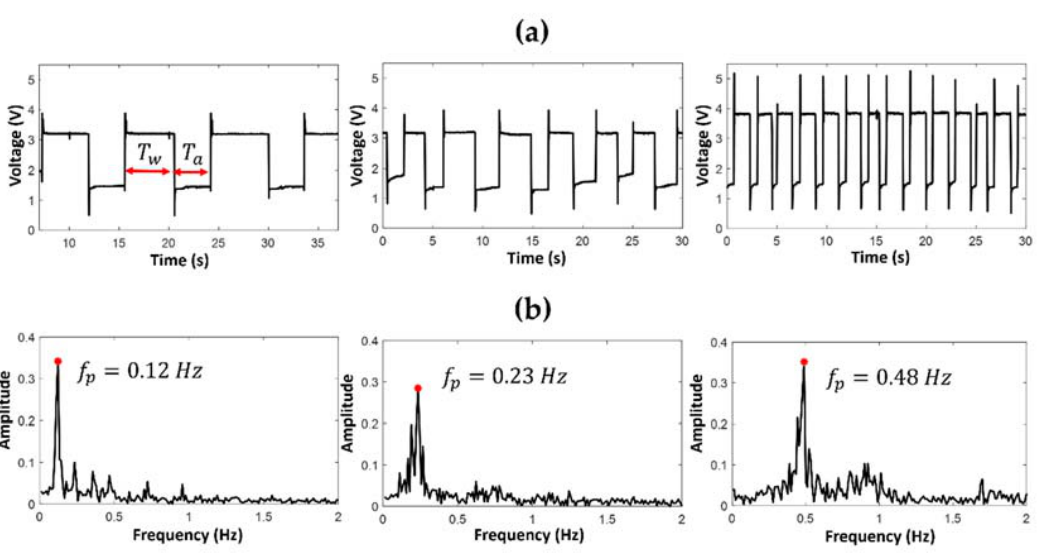
Figure 10. Optical acquisition for FLOW1 in ZnO-PDMS mofd using EXP1 combinations flow rate Vair = Vwater (0.1, 0.2, 0.3) mL/min: ( a ) the slug passage signals, and ( b ) the spectra.